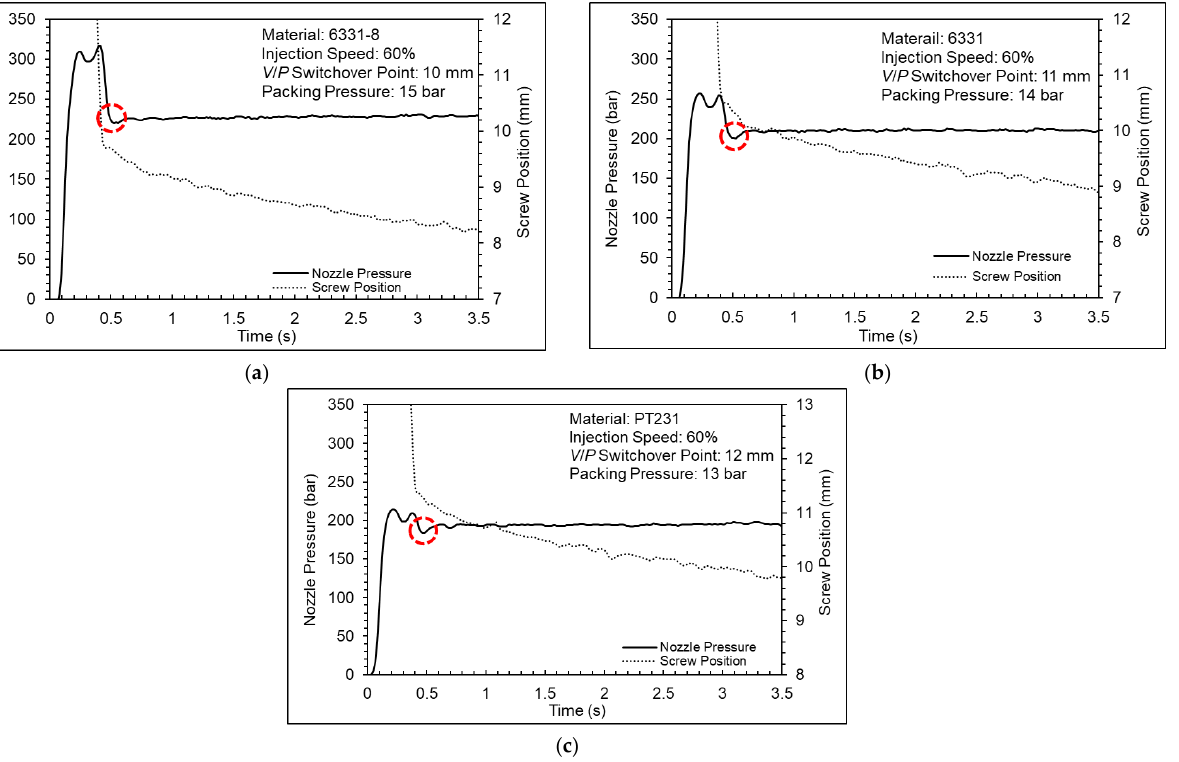
Figure 19. Nozzle pressure profile and screw stroke profile (( a ) 6331 − 8, ( b ) 6331, and ( c )